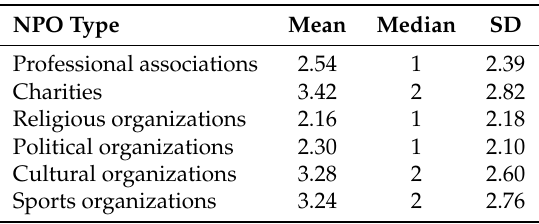
Table A2. Descriptives of interest in joining as a